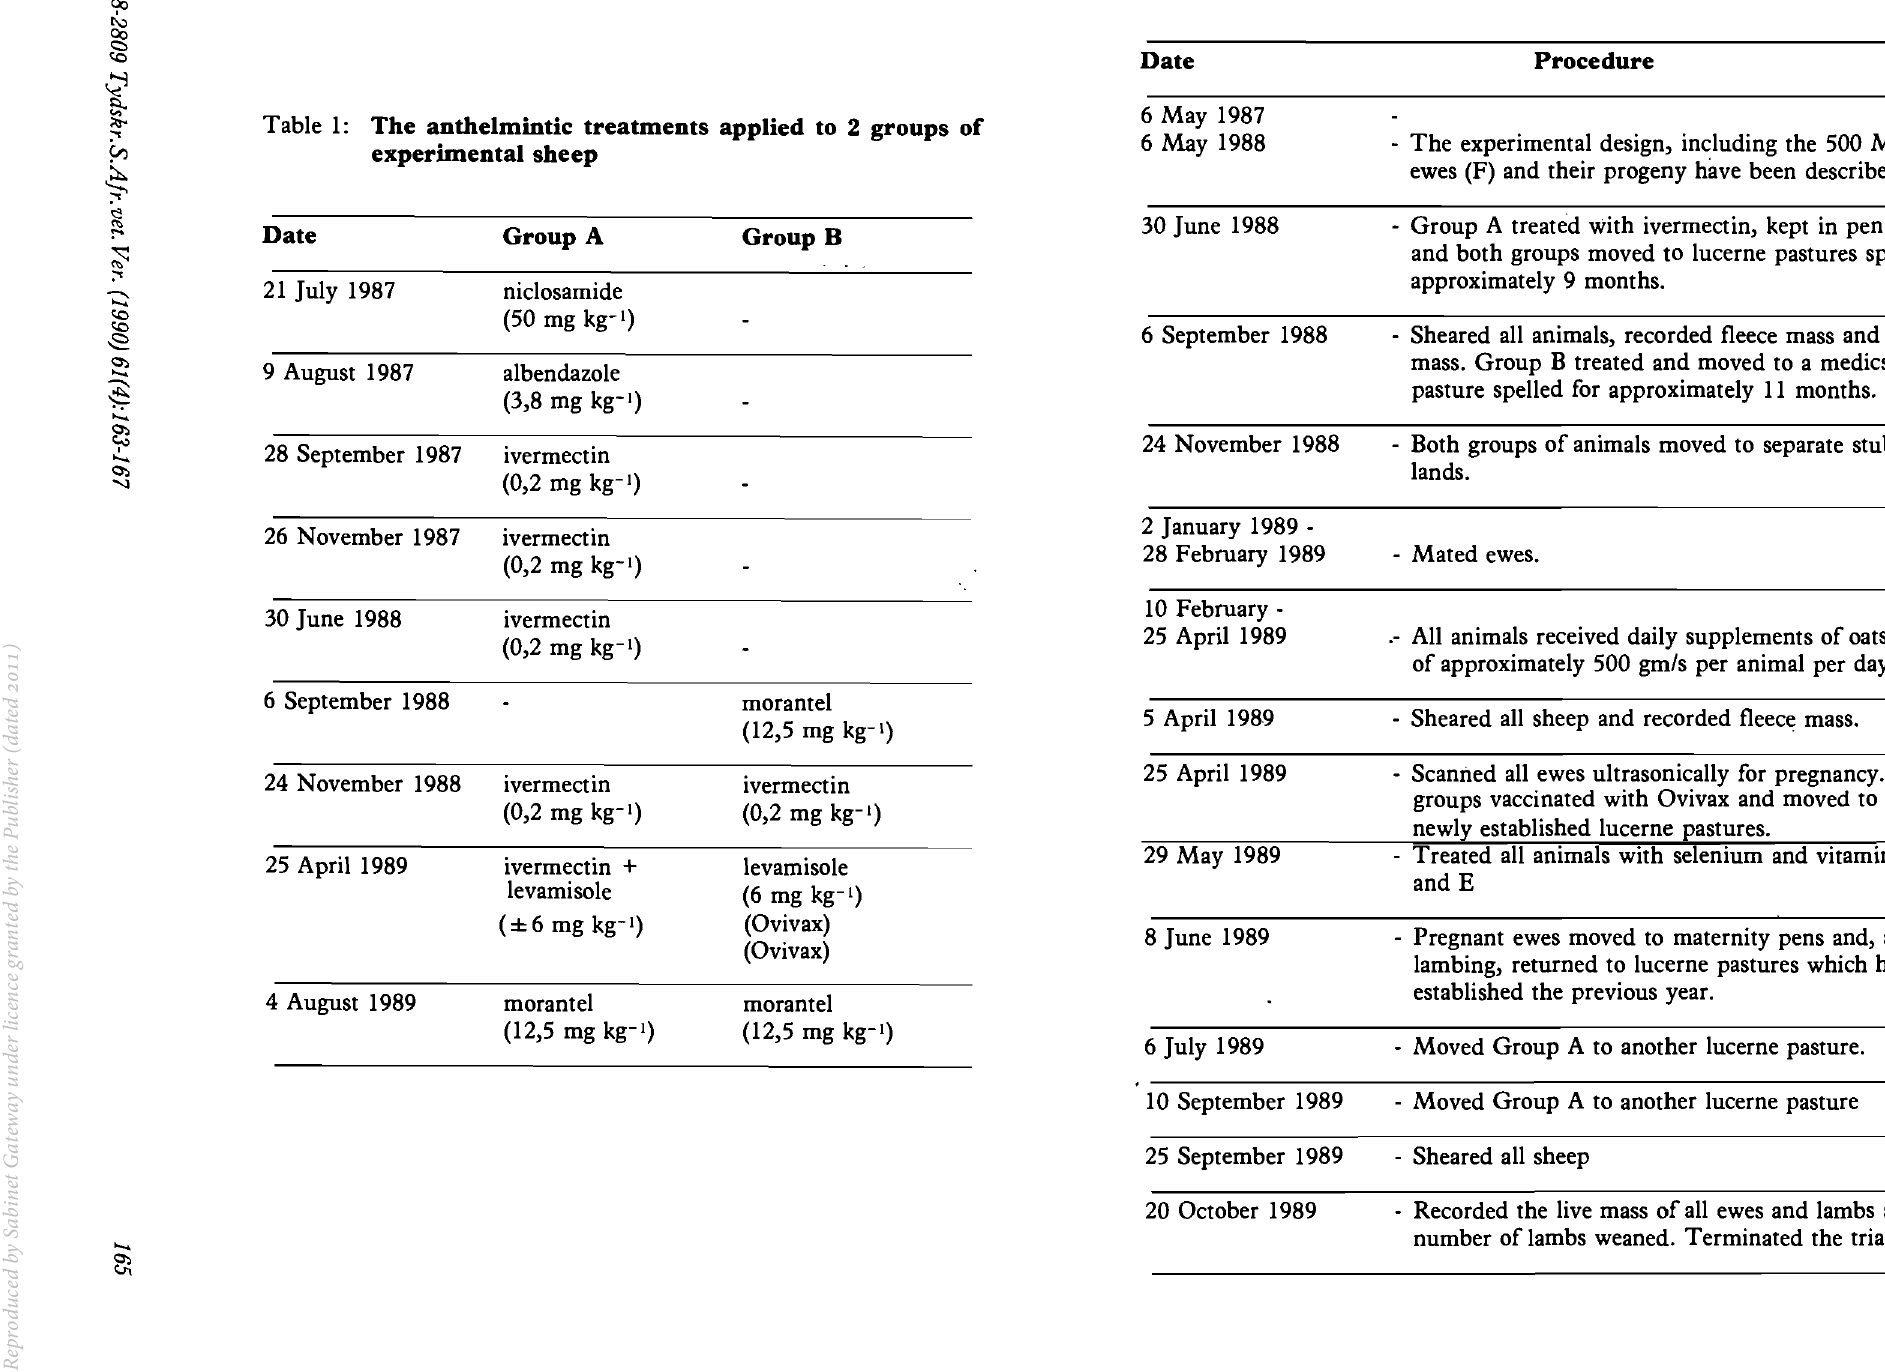
Table 1: The anthelmintic treatments applied to 2 groups of experimental sheep